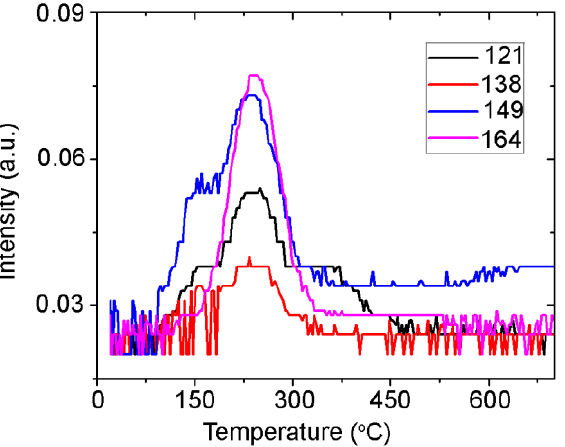
Figure 7. Deconvolution of the TPD-curve for the molecular ion of 4-vinylguaiacol with m/z 150 into separate Gaussians.